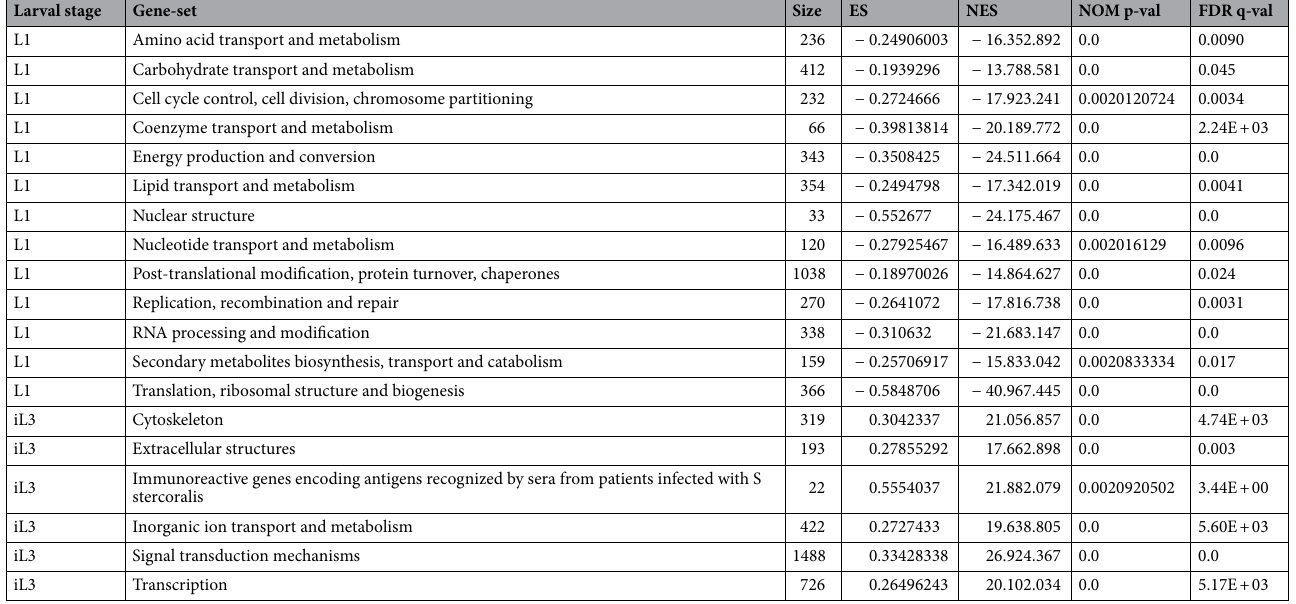
Table 2. Gene-set enrichment analysis in L1 and iL3. ES enrichment score, NES normalised enrichment score (accounts for differences in gene set size), NOM p-val nominal p-value, FDR q-val false discovery rate